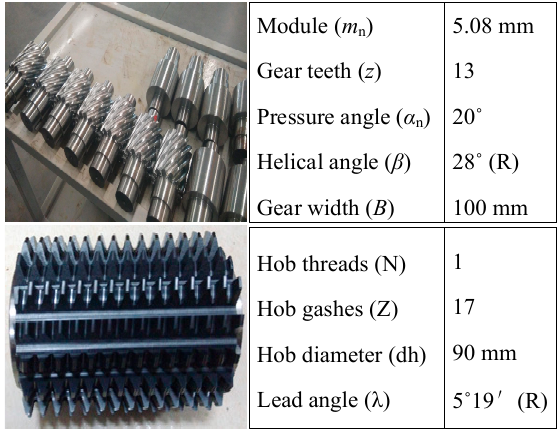
Table 2. Power input of spindle motor under different spindle speeds.